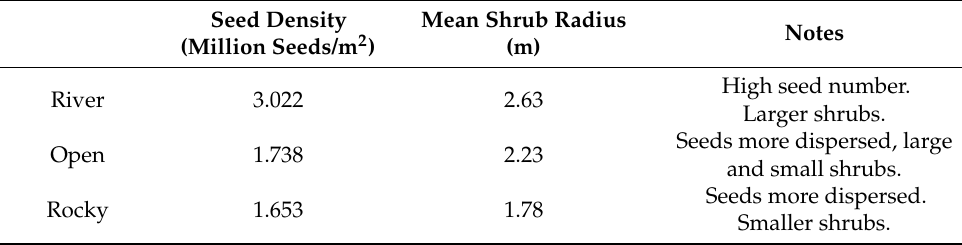
Table 1. Summary of the number of seeds per invasion site and shrub size for the three different terrains sampled in the